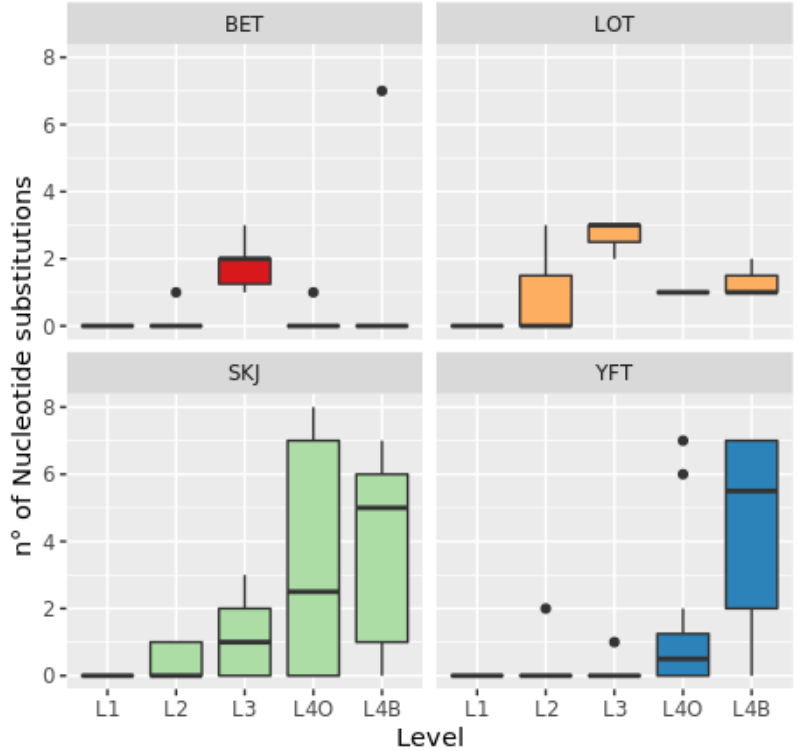
Figure 3. Box plots of nucleotide substitution counts at the four processing levels (L1–L4) and for the four target species: bigeye tuna (BET), longtail tuna (LOT), skipjack tuna (SKJ) and yellowfin tuna